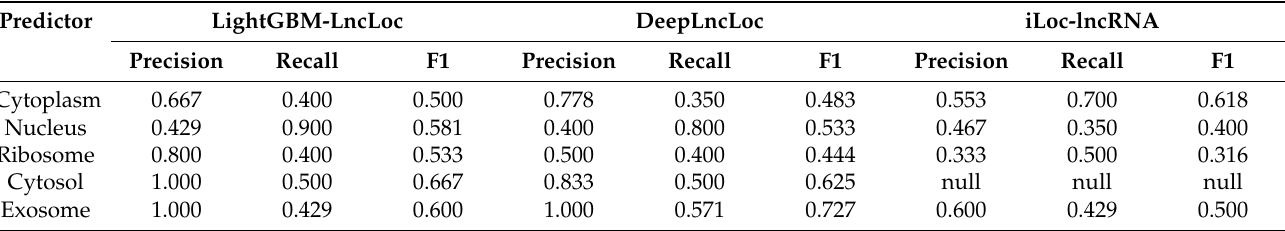
Table 7. Performance on the independent test.